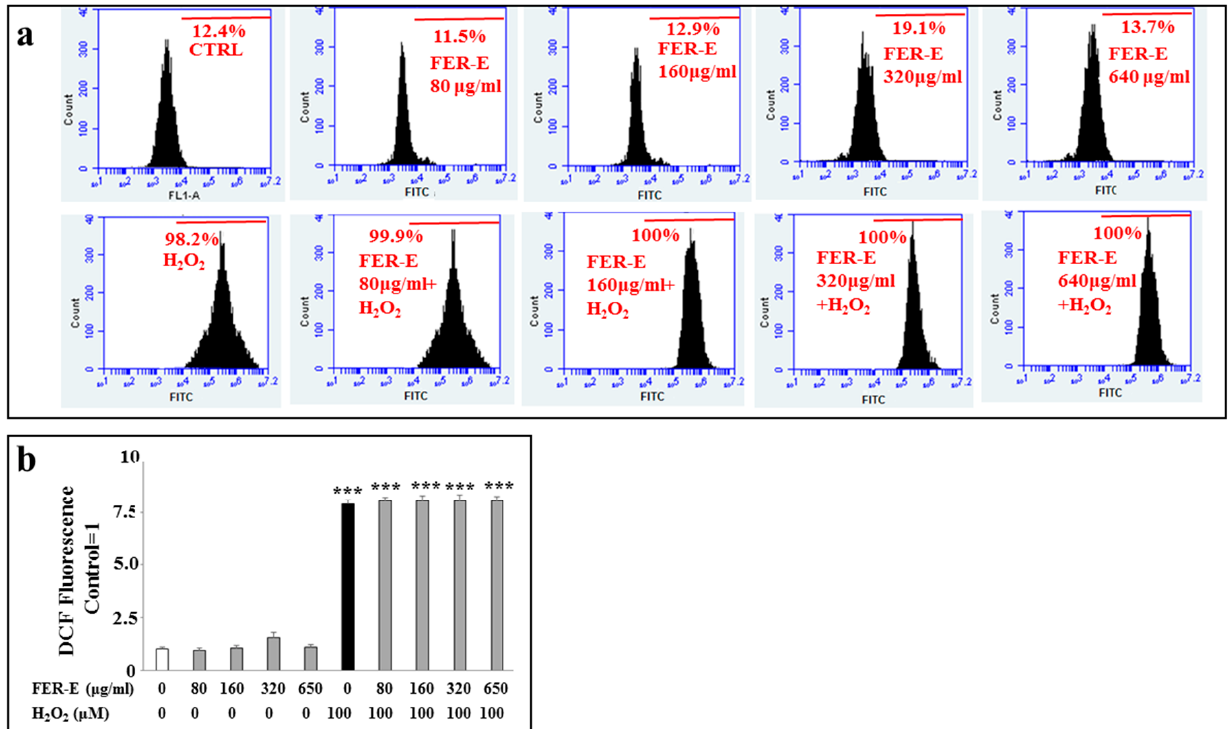
Figure 4. Measurement of the potential antioxidant activity in vitro of FER-E. In ( a ) the line colored in red, at the top of every plot, was drawn on the control and kept identical for all treatments. It identifies the percentage of cells that are included in the underlying area. The increase in ROS causes a shift on the right of the cell population. First of all, the oxidative capacity of FER-E (24 h) has been measured at different concentrations (80, 160, 320 and 650 µ g/mL). Subsequently, the potential antioxidant property of this extract was evaluated and H 2 O 2 (100 µ M for 30 min) was used as a positive control. In ( b ), a quantitative representation of the obtained data is shown. The fluorescence percentage of the control was arbitrarily set = 1 and all other values were compared to it. Three independent experiments were carried out, and the values were expressed as the mean ± sd. *** denotes p < 0.001 vs. the control. Analysis of Variance (ANOVA) was followed by a Tukey–Kramer comparison test.